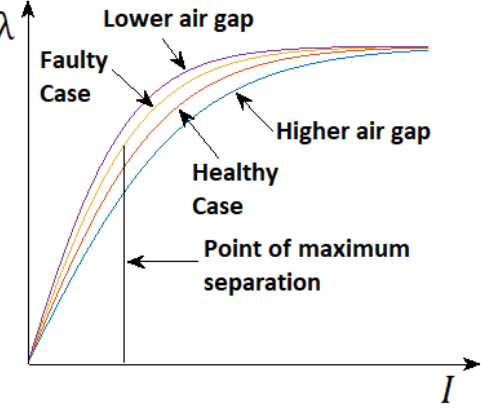
Figure 4. Saturation curve under healthy and eccentric conditions.